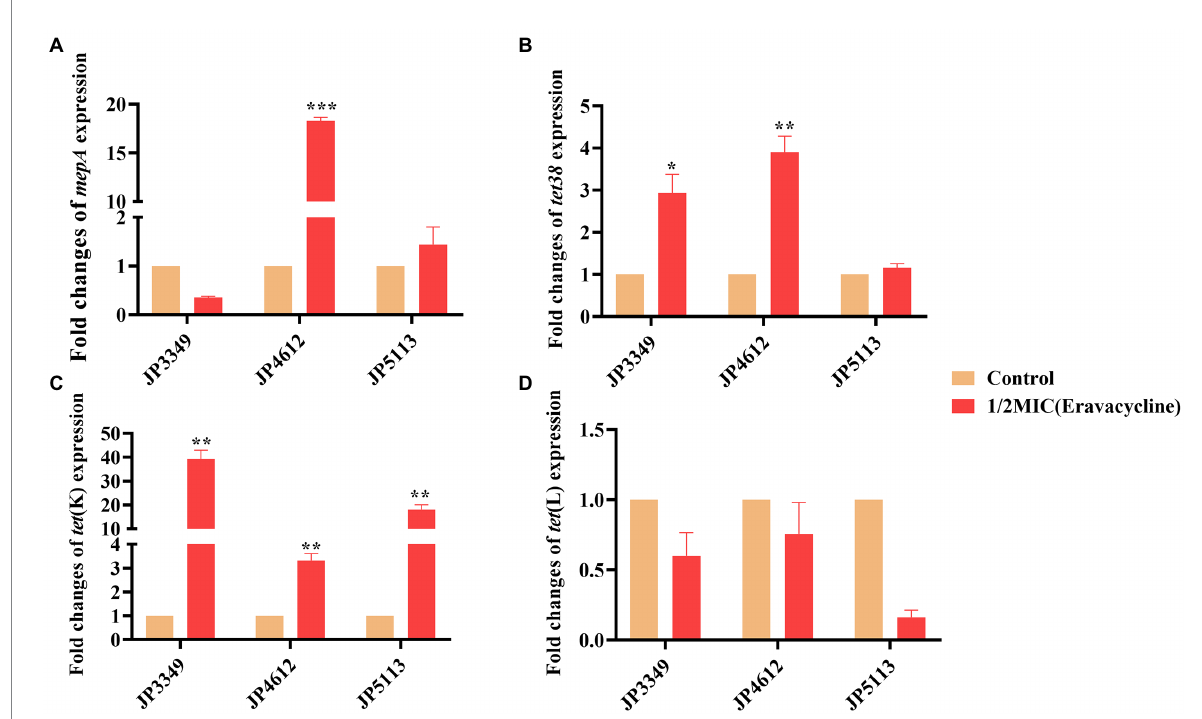
FIGURE 2 Fold changes in the expression of efflux pump-encoding genes in eravacycline-resistant Staphylococcus aureus exposed to 1/2 × MIC eravacycline concentrations. (A–D) The expression levels of mepA , tet38 , tet (K), and tet (L) genes. The values were normalized based on the internal control gene, gyrB . Data from the resistant strain with untreated 1/2 × MIC eravacycline were normalized to 1 to allow the comparison of data across different samples. Data represented the mean values from 3 independent experiments with error bars indicating standard deviations, and asterisks denoted the significance of differences in the expression by paired Student’s t -test (** p < 0.01; *** p <